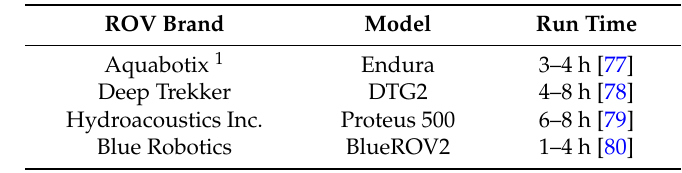
Table 3. Run times for micro inspection-class ROVs battery